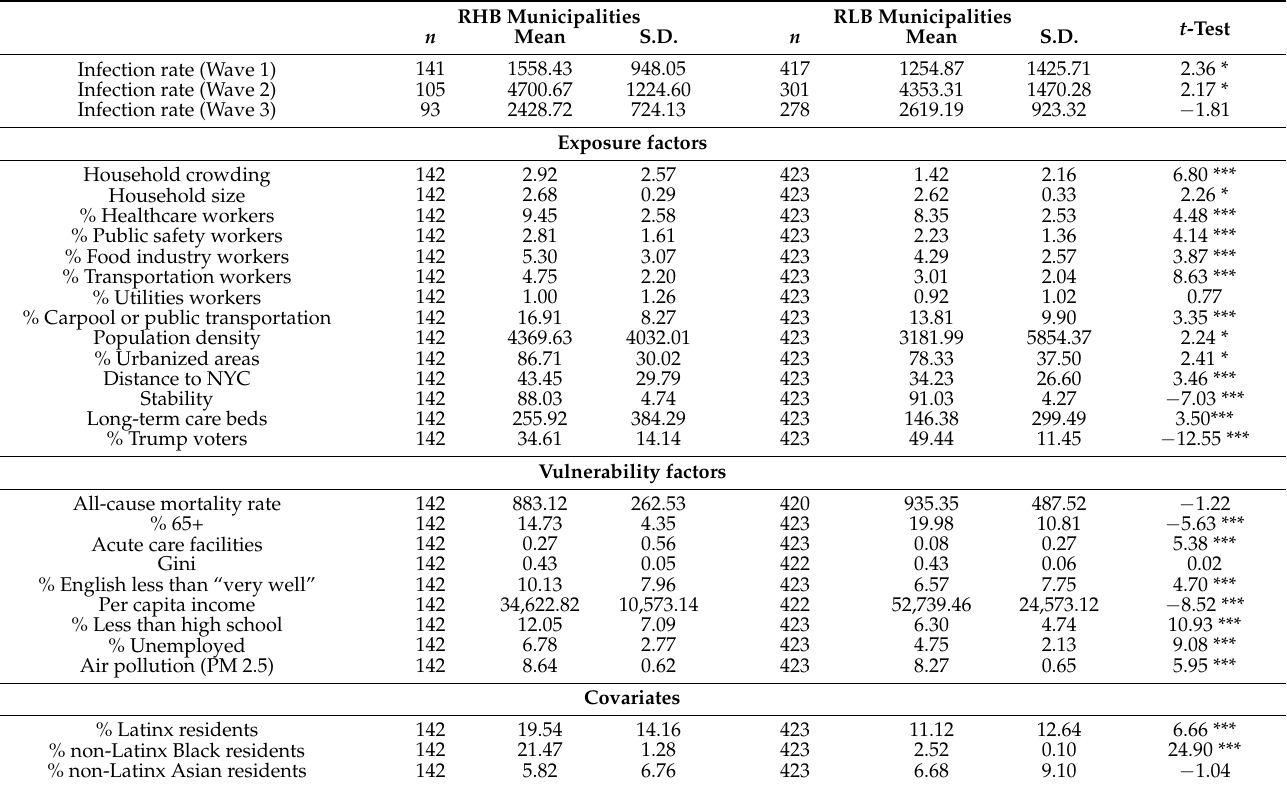
Table A4. Descriptive statistics by RHB and RLB